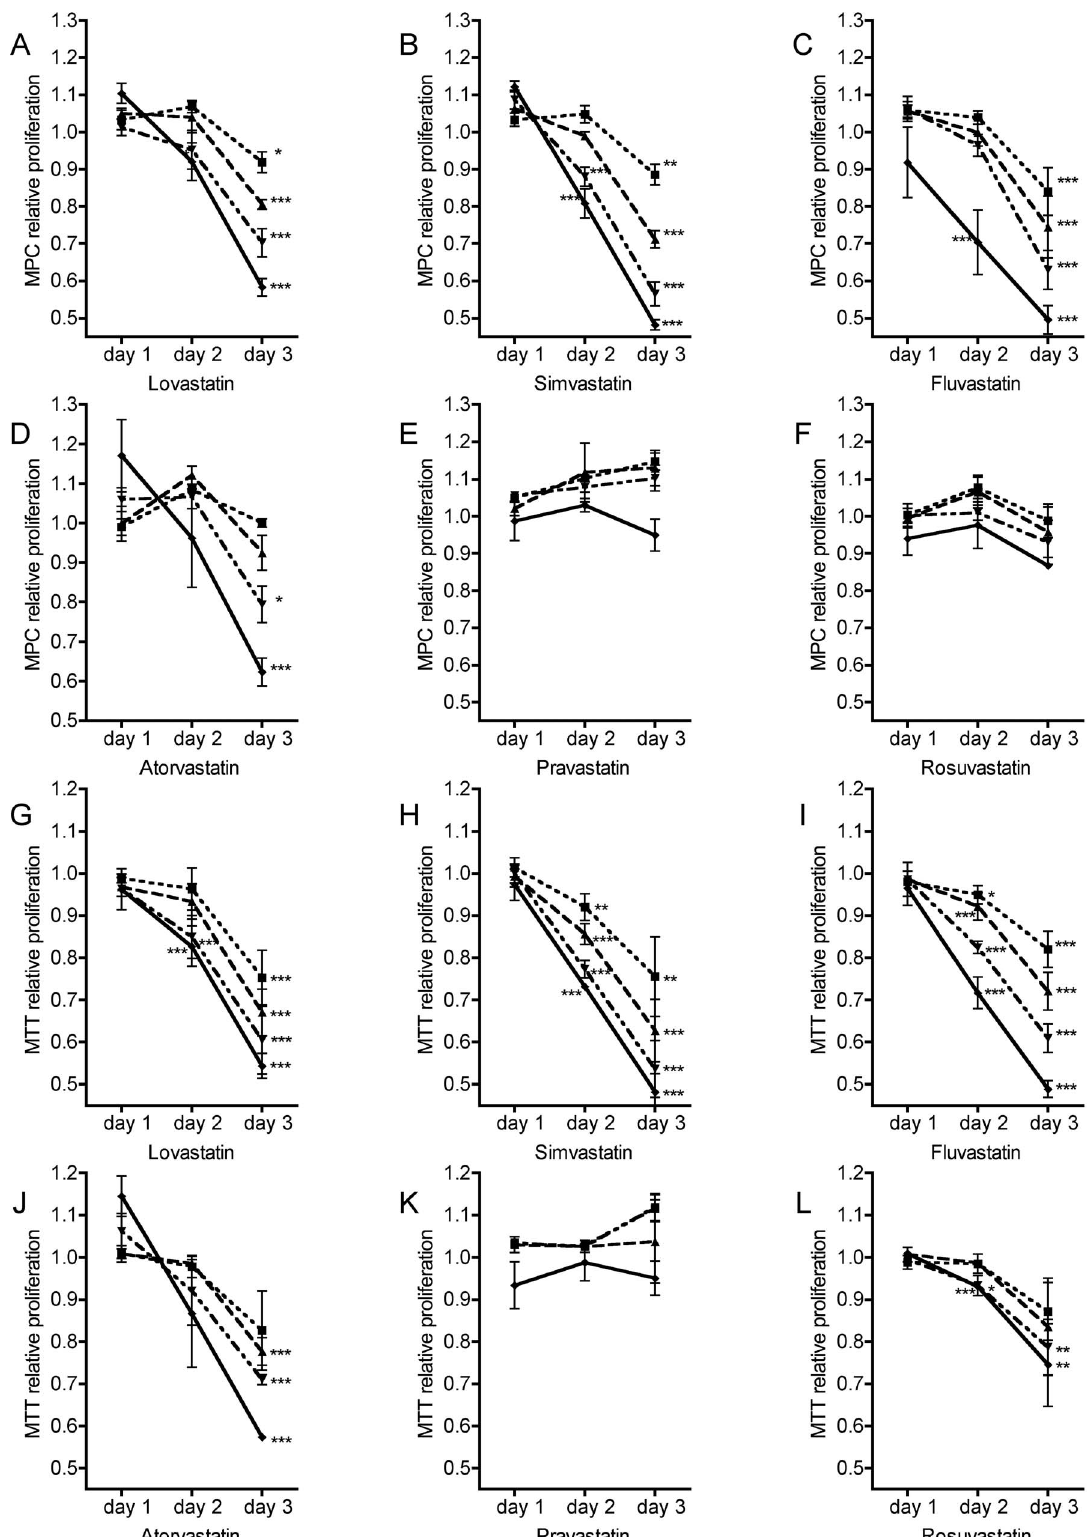
Figure 3. Relative proliferation of MPC and MTT under statin treatment. MPC (A–F) and MTT (G–K) were treated with & 6.25 m M, m 12.50 m M, . 25.00 m M, and X 50.00 m M of atorvastatin, fluvastatin, lovastatin, pravastatin, rosuvastatin, and simvastatin for 24, 48, and 72 hours.